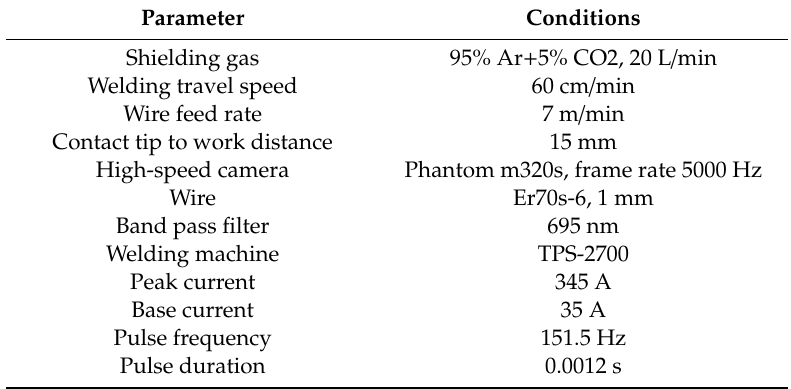
Table 1. Experiment conditions. Table 2. Chemical composition (typical).